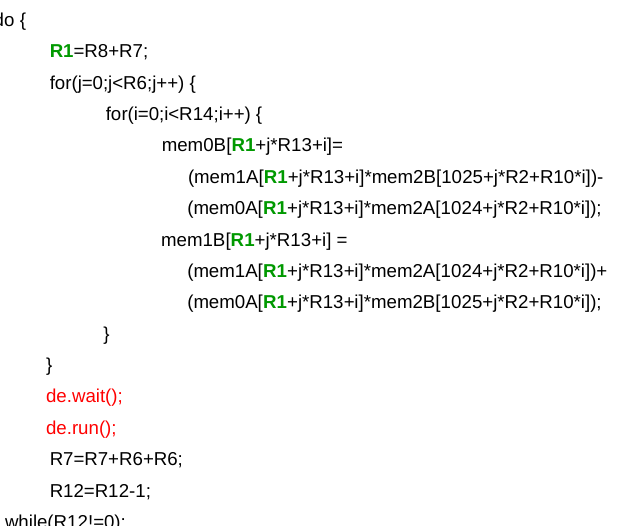
Figure 10. Self and partial reconfiguration